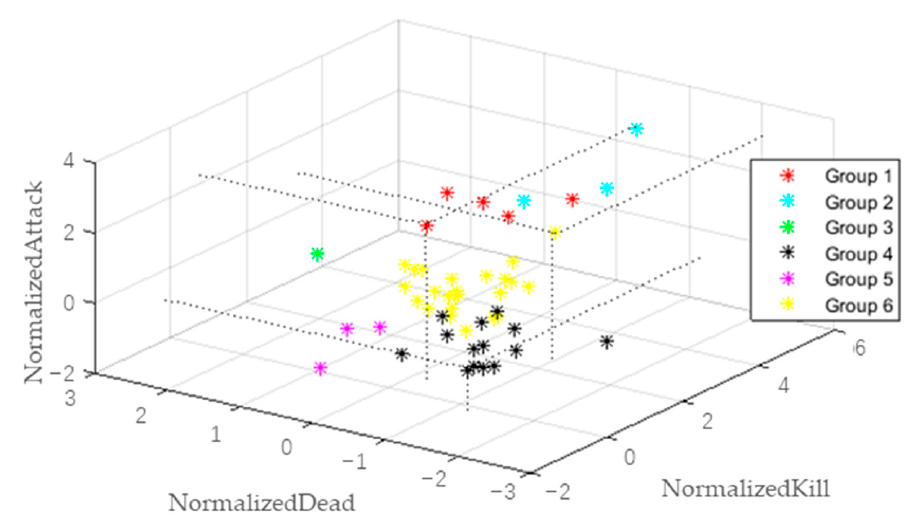
Figure 5. Classification of HEXACO-60 participants, based on the centroids of the K-means clusters.